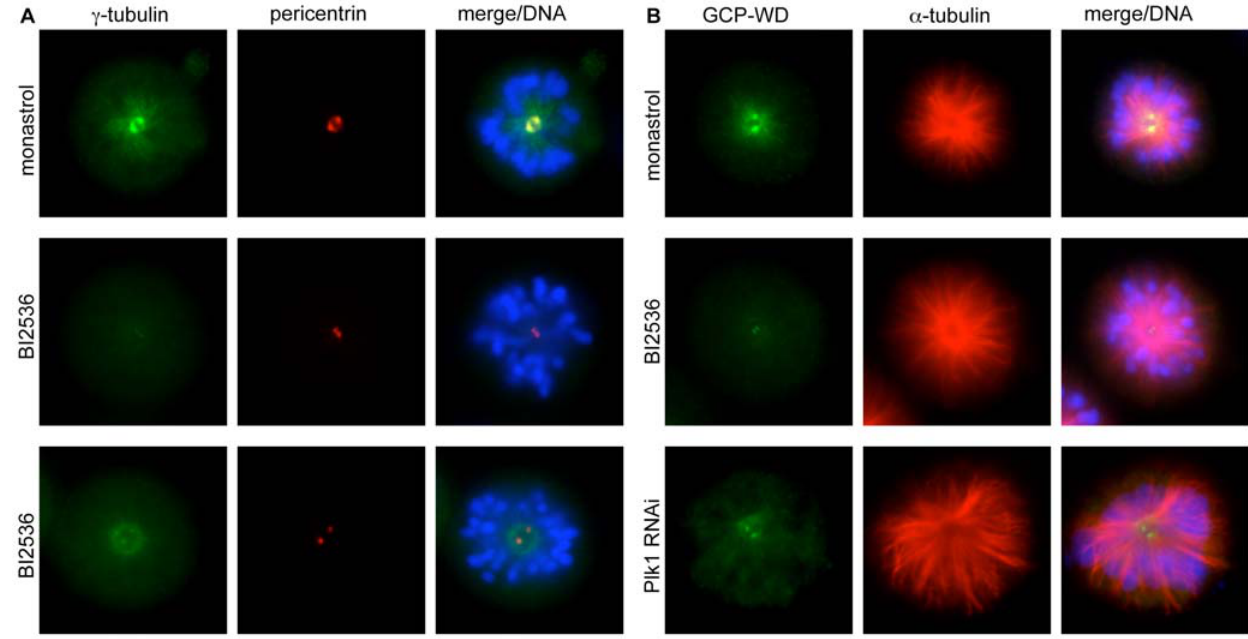
Figure 1. Plk1 activity is required for localization of c -tubulin and GCP-WD to centrosomes and spindle microtubules. (A) HeLa cells treated with monastrol or BI2536 were fixed and immunostained for c -tubulin and pericentrin.DAPI was used to label DNA. (B) HeLa cells treated with monastrol, BI2536 or siRNA against Plk1 were fixed and immunostained for GCP-WD and a -tubulin. DNA was visualised using DAPI.